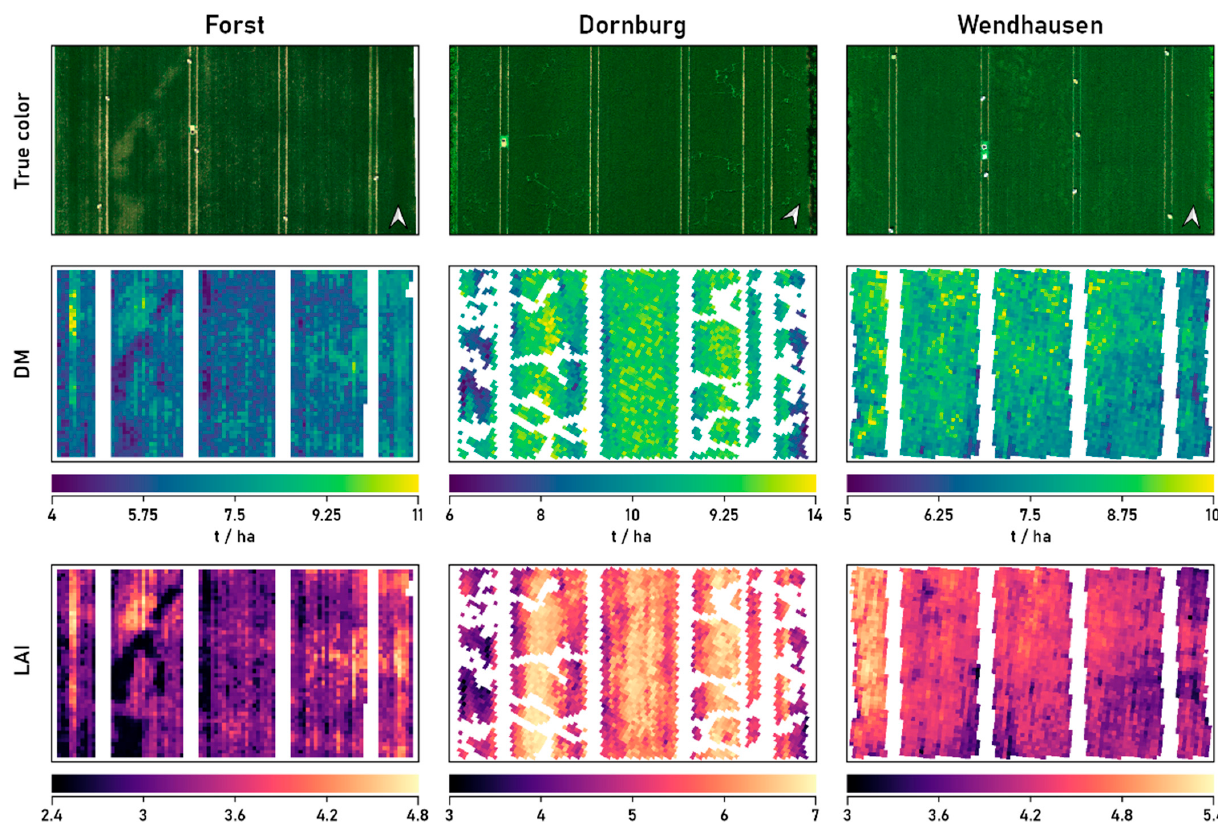
Figure 6. Predicted maps for barley DM and LAI at milk ripeness (BBCH 75) at three study sites. Color scales differ between sites for improved visibility of spatial variability. Maps for AFS sites Dornburg and Wendhausen were rotated (see north arrow in true color map). Gaps in maps for Dornburg stem from damage done to barley plants during fieldwork (mixed 1 m pixels were deleted generally to prevent misinterpretation of erroneous spatial patterns).